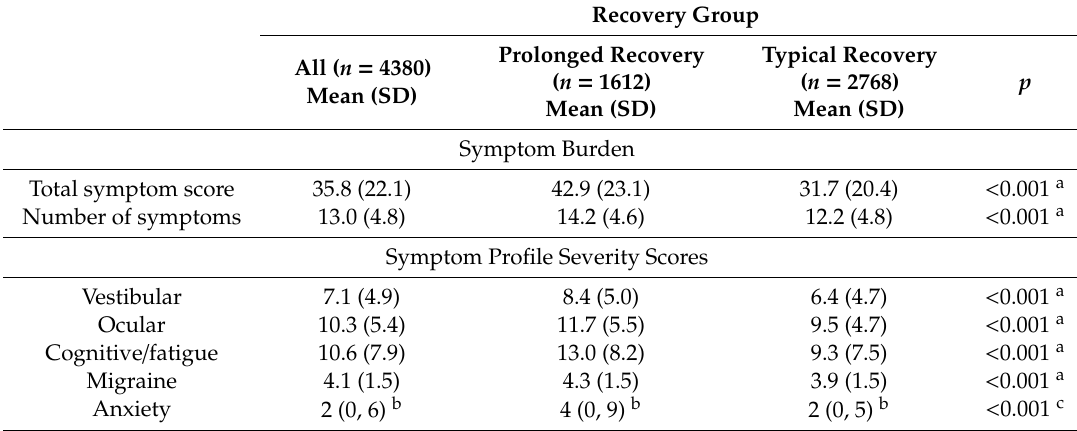
Table 3. Symptom Burden and Symptom Profiles at Time of Injury by Recovery